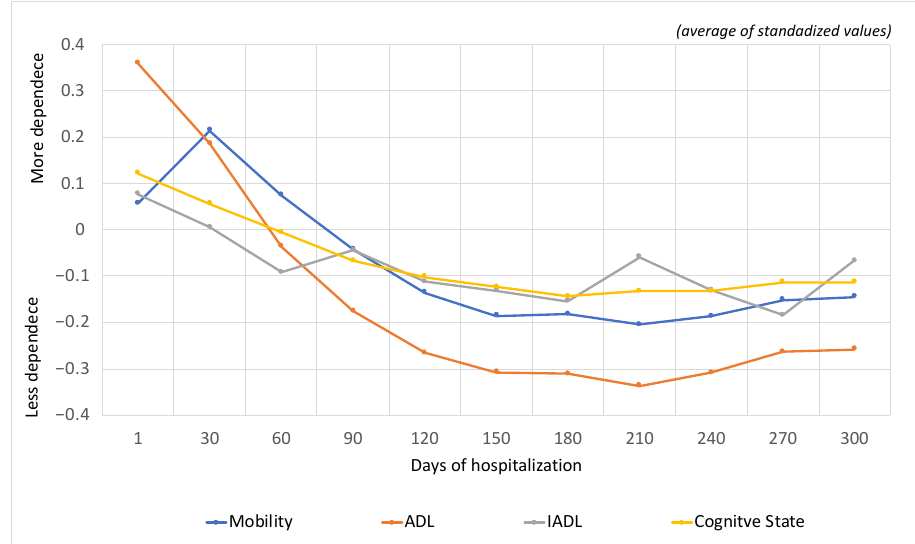
Figure 1. Synthetic indices: mobility, basic activities of daily living, instrumental activities of daily living and cognitive status in the Medium Term and Rehabilitation Units (mean of standardized values) .